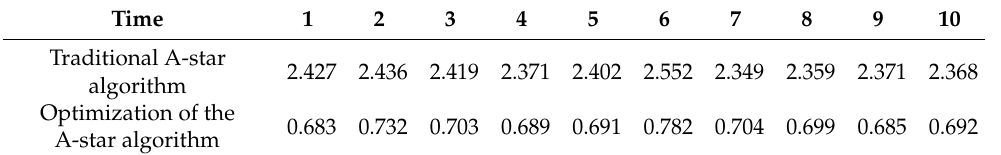
Table 3. Comparison of path-planning times for complex maps (unit: